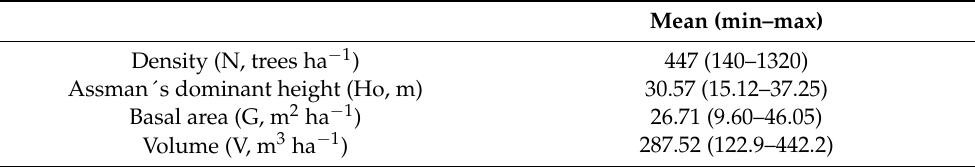
Table 1. Silvicultural characteristics of Pinus radiata stands in the Ñuble Region (Chile, N = 48 field plots).